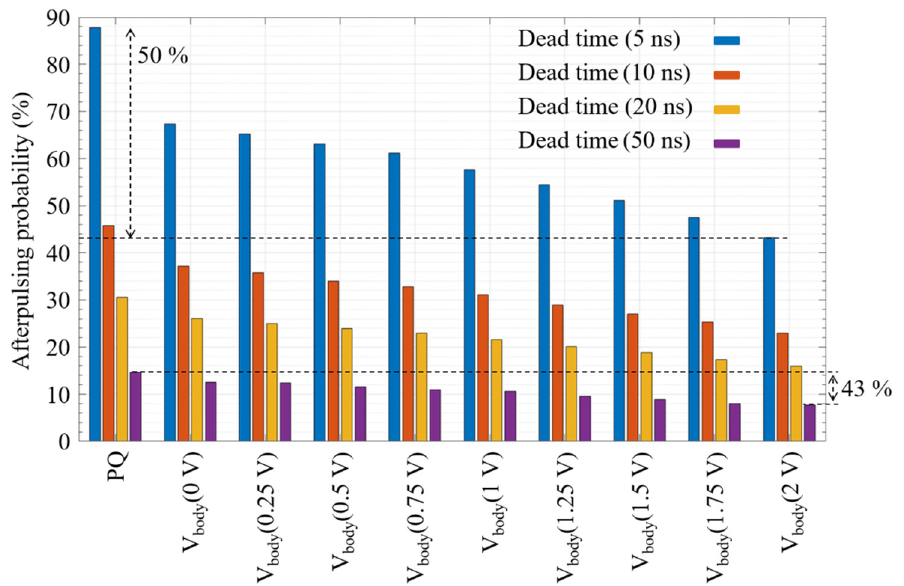
Figure 12. Afterpulsing probability in the PQ and the AQ with different body voltages for hold-off